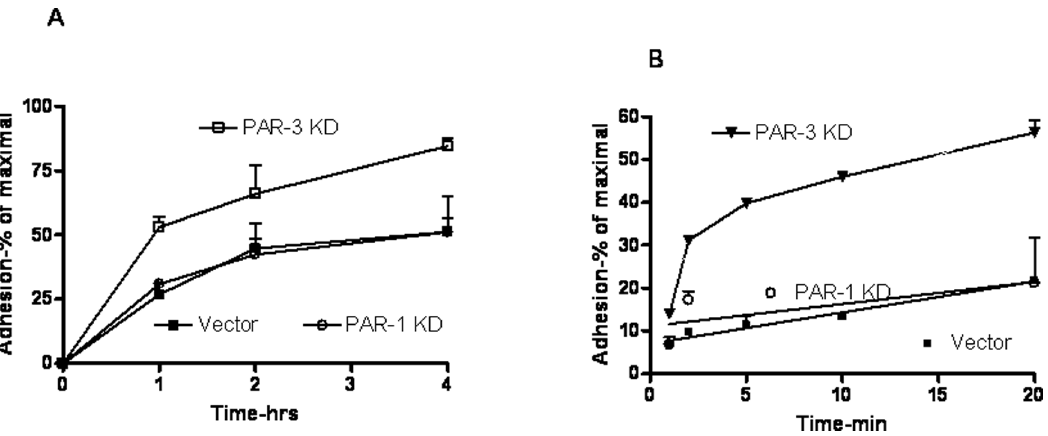
Figure 1. Adhesion kinetics of vector-control and PARs KDs cells. Cells of the desired PANC-1 variants were seeded at 10,000/well in a 96- wells cluster as described in Methods. At the indicated time points non-adherent cells were removed to a new well and the adherent cells number quantified by the MTT assay. All values were normalized to maximal adhesion (overninght incubation, usually . 90% adhesion). A – adhesion kinetics to tissue-culture-treated clusters; B – Adhesion kinetics to Matrigel-coated (0.2 mg/ml for 1 h). Results represent mean 6 SE of 3–5 independent experiments performed in triplicates or tetraplicates.